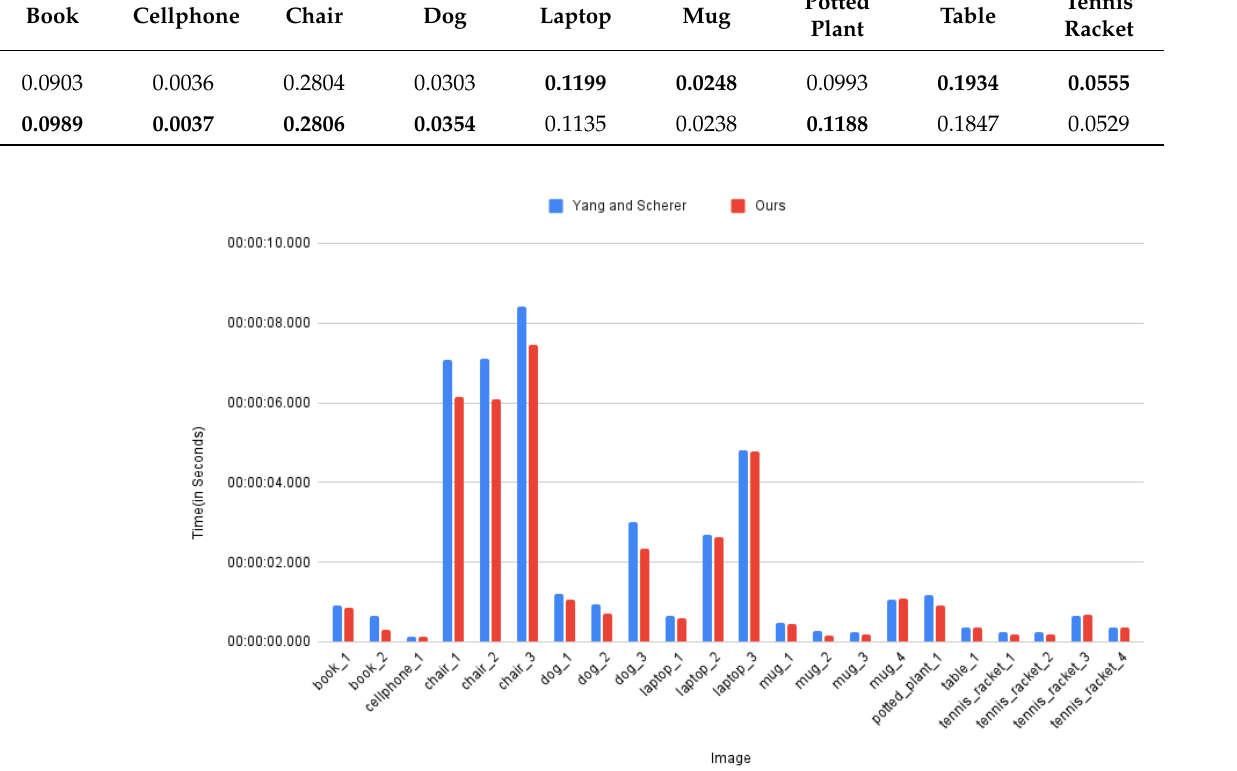
Figure 5. Comparison graph for time taken (in seconds) by [26] and our